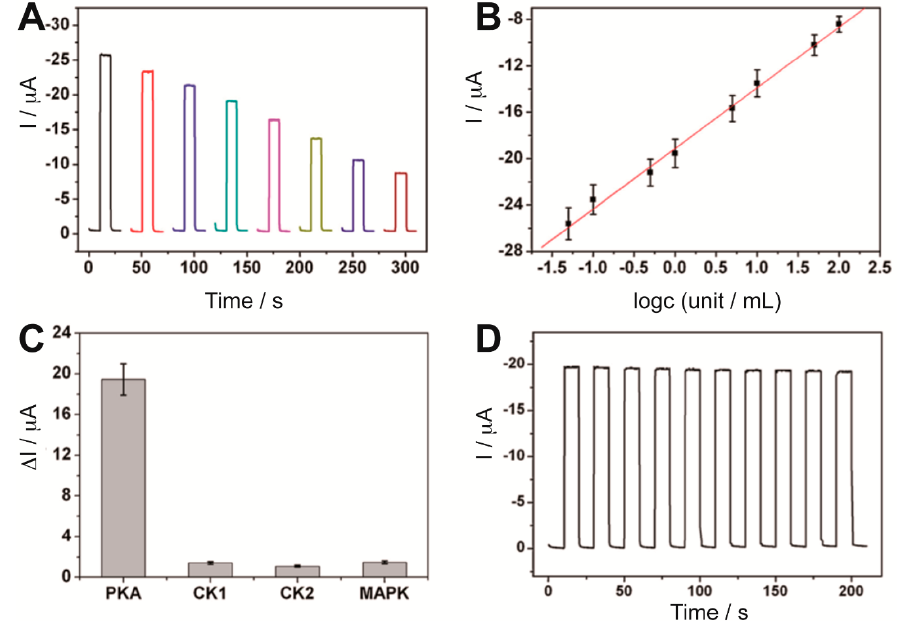
Figure 5. ( A ) Photocurrent response of the PEC biosensor based on biotinylated Phos-tag specific recognition for protein kinase A (PKA)-phosphorylated peptides in the presence of increasing concentrations of PKA (from left to right). ( B ) Photocurrent vs. logarithm of PKA concentration calibration plot. ( C ) Biosensor selectivity after incubation of the peptide-Bi 2 S 3 -AuNPs-ITO electrodes with different protein kinases. ( D ) Stability of the photocurrent response upon chopped-irradiation. Reprinted with permission from ref. [72].